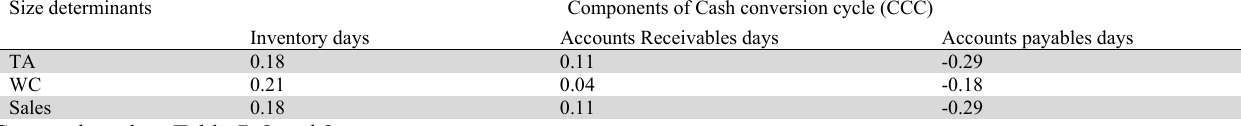
Summary of relational co-movement (r s ) of firm’s size determinants and CCC components Size determinants